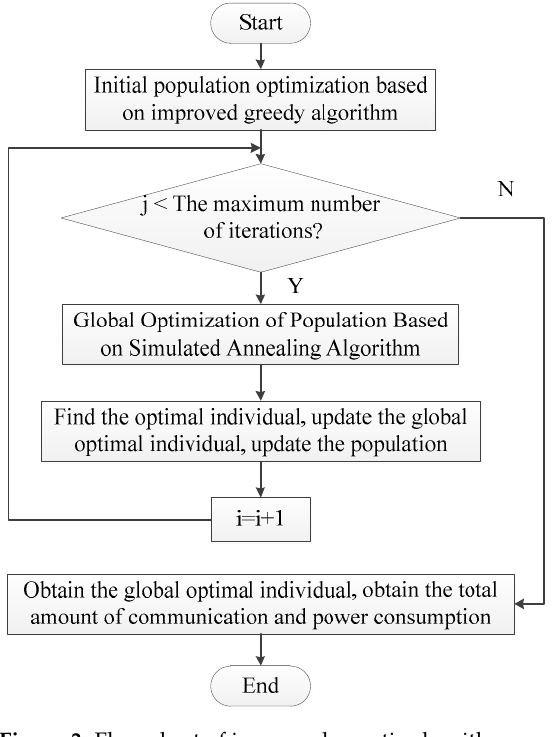
Figure 3. Flow chart of improved genetic algorithm.